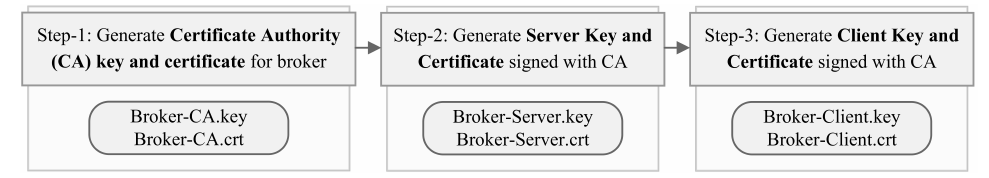
Figure 5. Securing steps for MQTT broker.